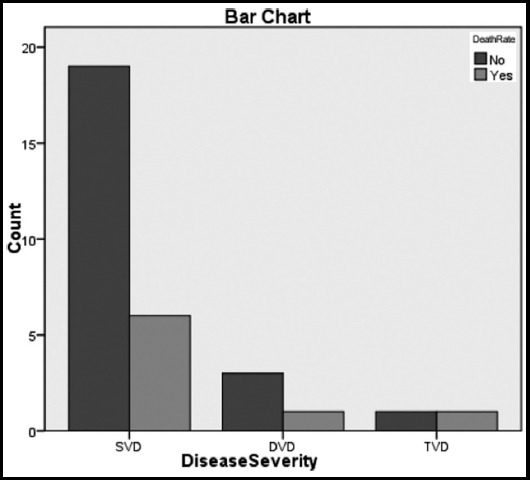
Disease Severity among survivors and non-survivors.